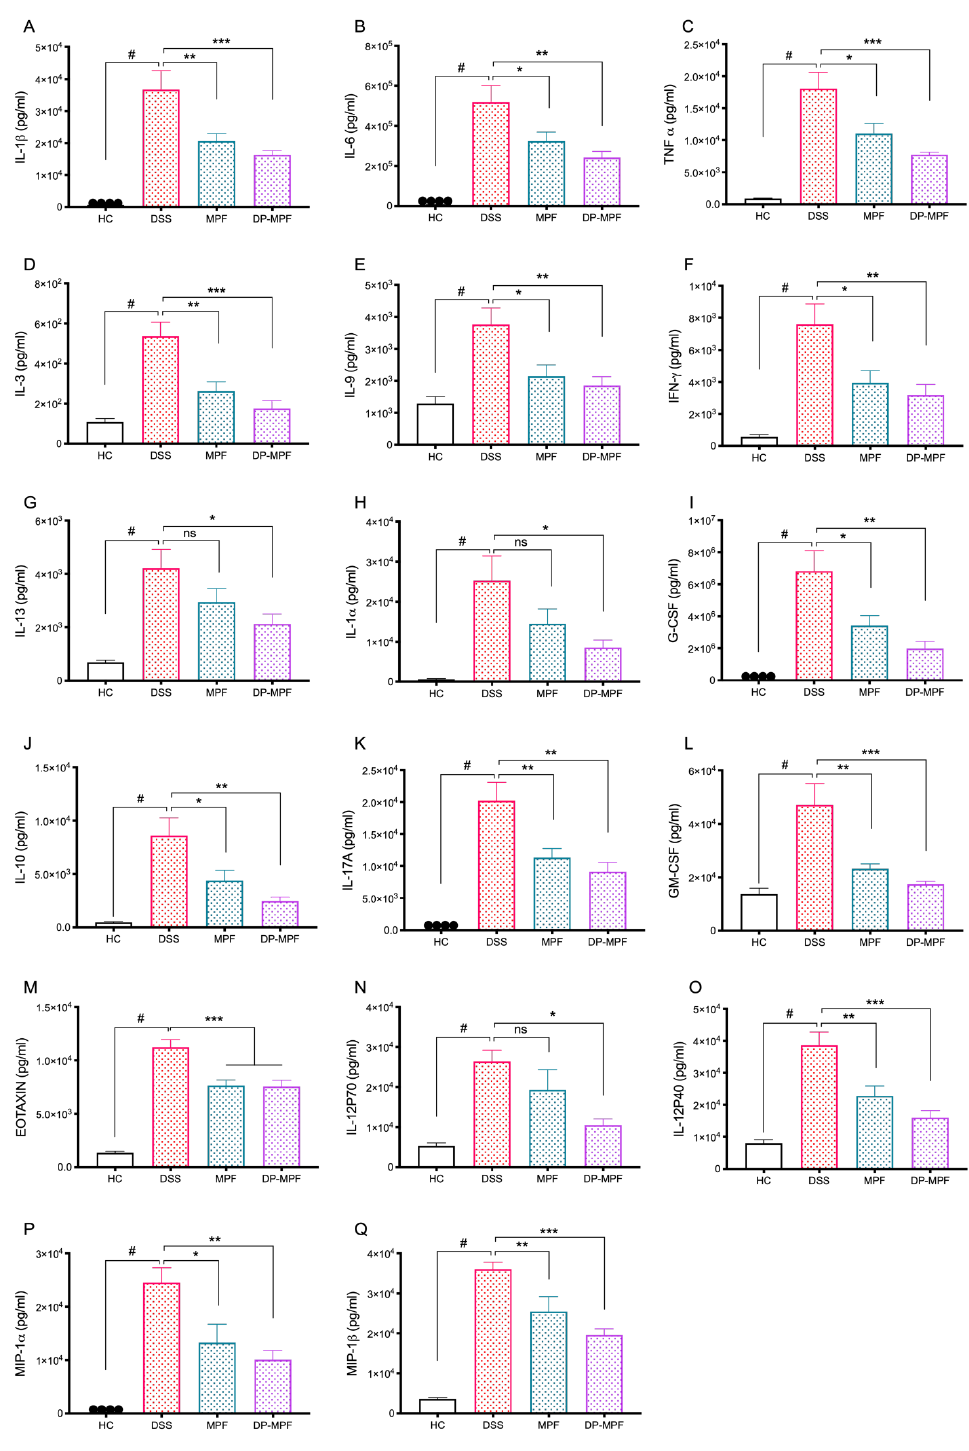
Figure 5. Effect of MPF and DP-MPF treatments on cytokine levels from DC tissues in DSS-induced acute colitis model. ( A ) IL-1 β , ( B ) IL-6, ( C ) TNF- α , ( D ) IL-3, ( E ) IL-9, ( F ) interferon- γ (IFN- γ ), ( G ) IL-13, ( H ) IL-1 α , ( I ) G-CSF, ( J ) IL-10, ( K ) IL-17A, ( L ) GM-CSF (granulocyte colony-stimulating factor), ( M ) Eotaxin, ( N ) IL-12 (P70), ( O ) IL-12 (P40), ( P ) macrophage inflammatory protein (MIP-1 α ), ( Q ) MIP-1 β , Data expressed as a mean ± SEM ( n = 8/group). Statistical significance was evaluated using one-way ANOVA followed by Tukey’s post-test. A p -value of <0.05 was considered significant, non-significant (ns); * p < 0.05, ** p < 0.01, and *** p < 0.00001. # Significant effect HC vs. DSS ( p < 0.05); * Significant effect treatment vs. DSS (DSS vs. MPF) or (DSS vs.